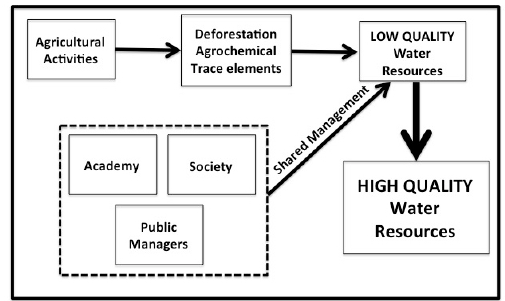
Figure 2. Schematic representation of shared actions among academia, managers and society in favor of improving the quality of water